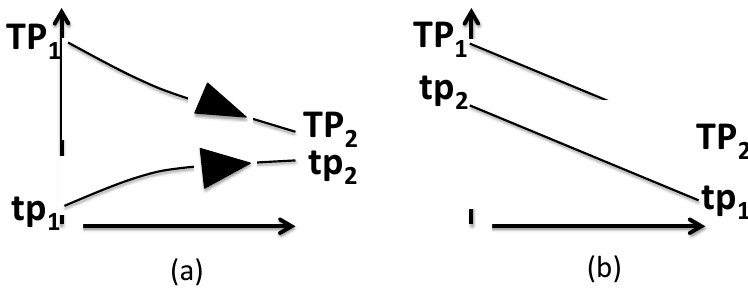
Figure 4. Logarithmic Mean Temperature Difference (LMTD) Co ‐ Current ( a ) and Counter ‐ Current ( b ) Flows for the Precooler. TP 1 and tp 1 represent the inlet temperatures of the coolant and heat sink (seawater), respectively. TP 2 and tp 2 represent the outlet temperatures of the coolant and heat sink, respectively. ( a ) shows that the flows are parallel to each other, indicating a bigger precooler but with a modest exit temperature of the heat sink (tp 2 ); ( b ) shows that the flows are in opposite directions and ensures better heat exchange, therefore the size of the counter ‐ current precooler is significantly reduced but with potentially higher exit heat sink temperature (tp 2 ).